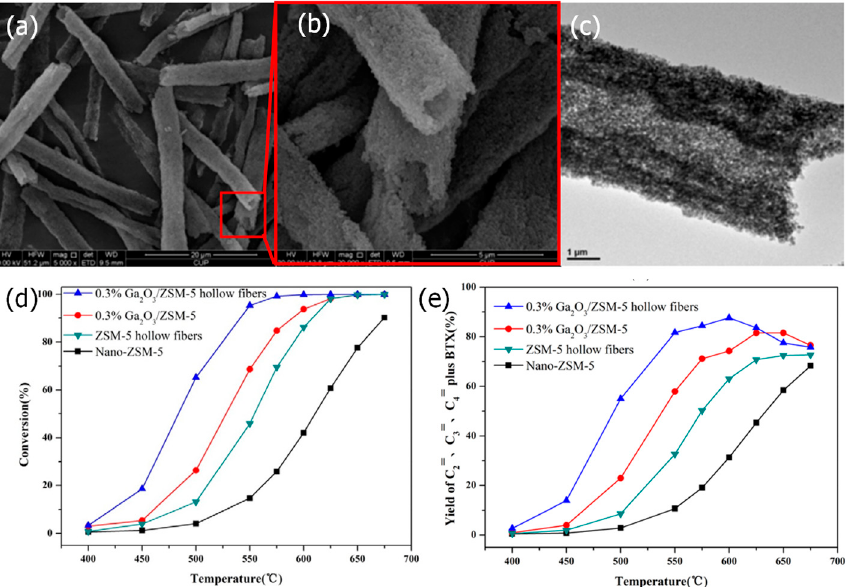
Figure 6. The low ( a ) and magnified ( b ) SEM image and TEM image ( c ) of Ga 2 O 3 /ZSM-5 hollow fibers. Butane conversion ( d ) and C2 = –C4 = yield ( e ) over as-prepared Ga-based catalysts over catalytic cracking of n − butane. (Figure ( b ) is the magnified image of red box in figure ( a )).